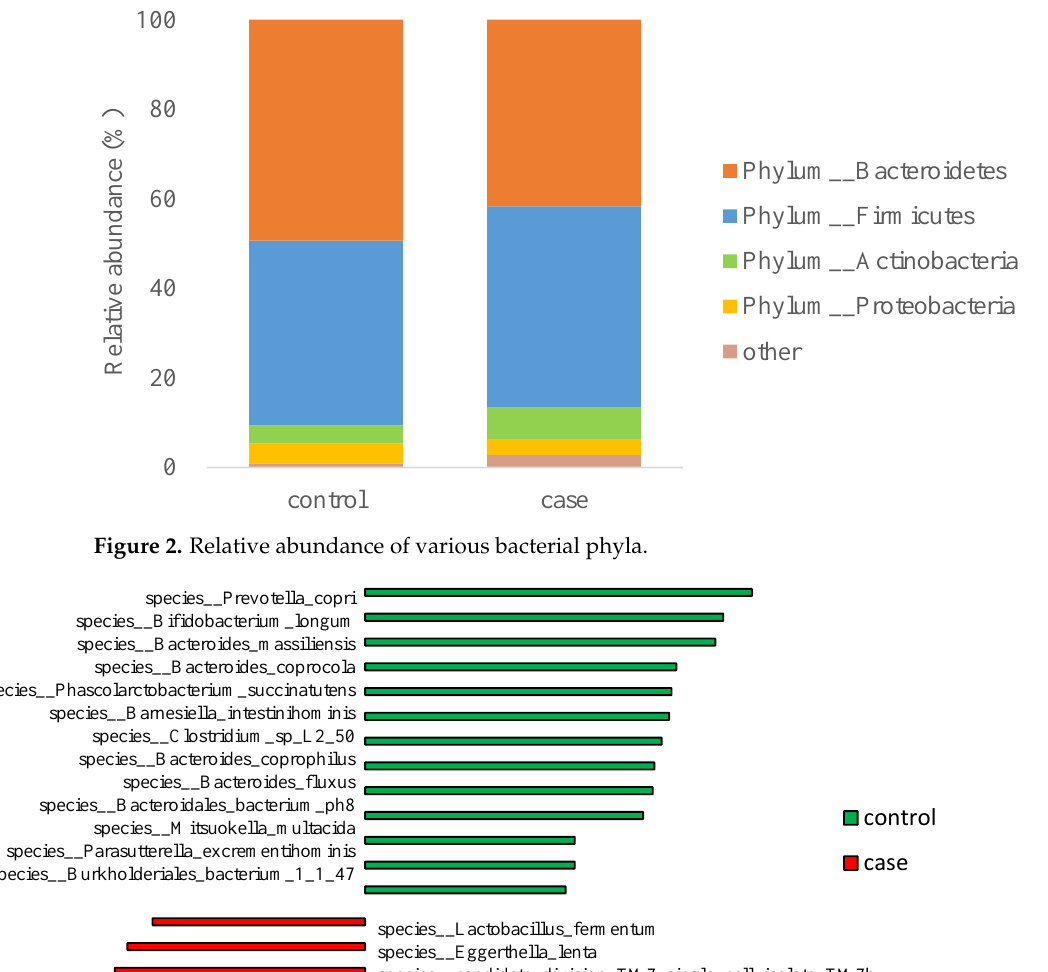
Figure 2. Relative abundance of various bacterial phyla.